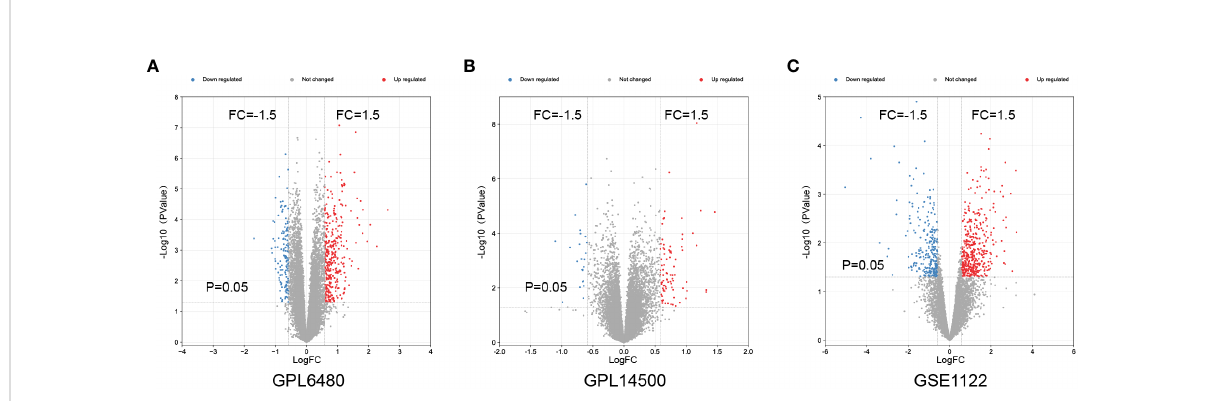
FIGURE 4 Differential expressed genes analysis. Volcano maps of GPL6480 (A), GPL14500 (B) in GSE47460 and GSE1122 (C) .